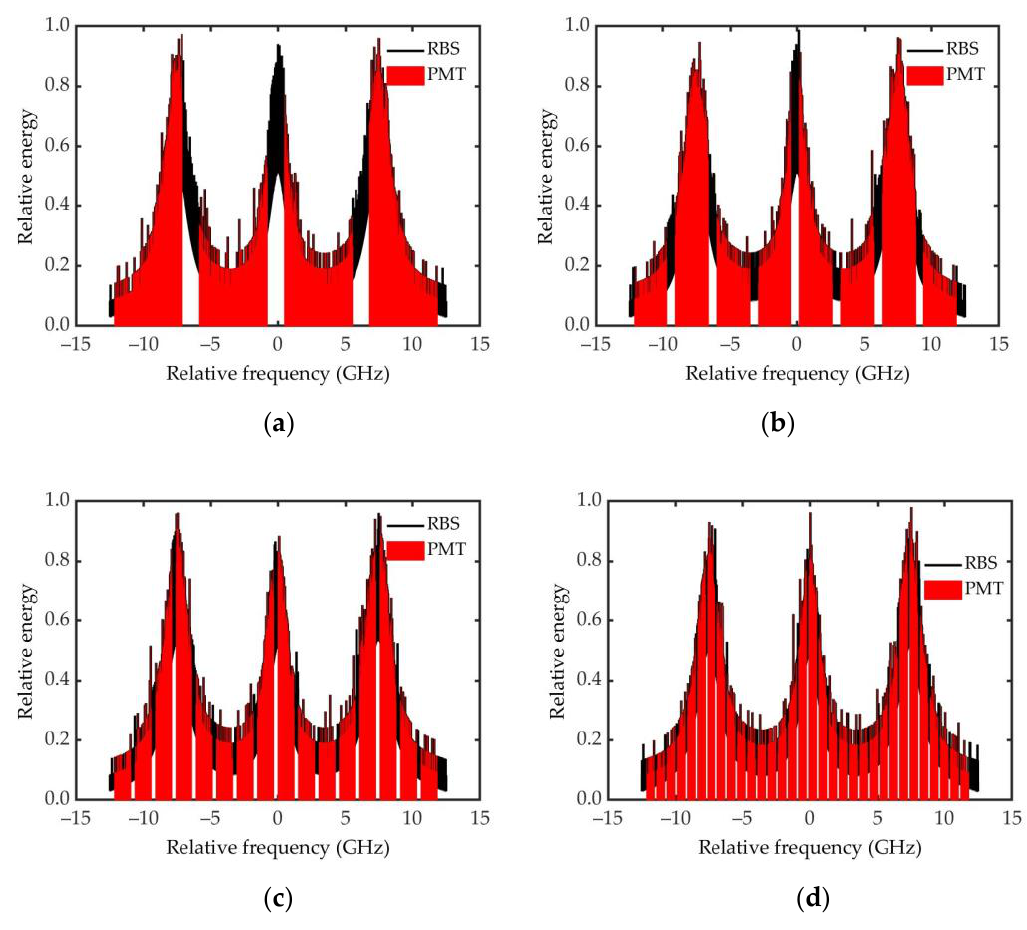
Figure 3. RB scattering spectrum obtained under different channel numbers of the PMT: ( a ) 4; ( b ) 8; ( c ) 16; and ( d )